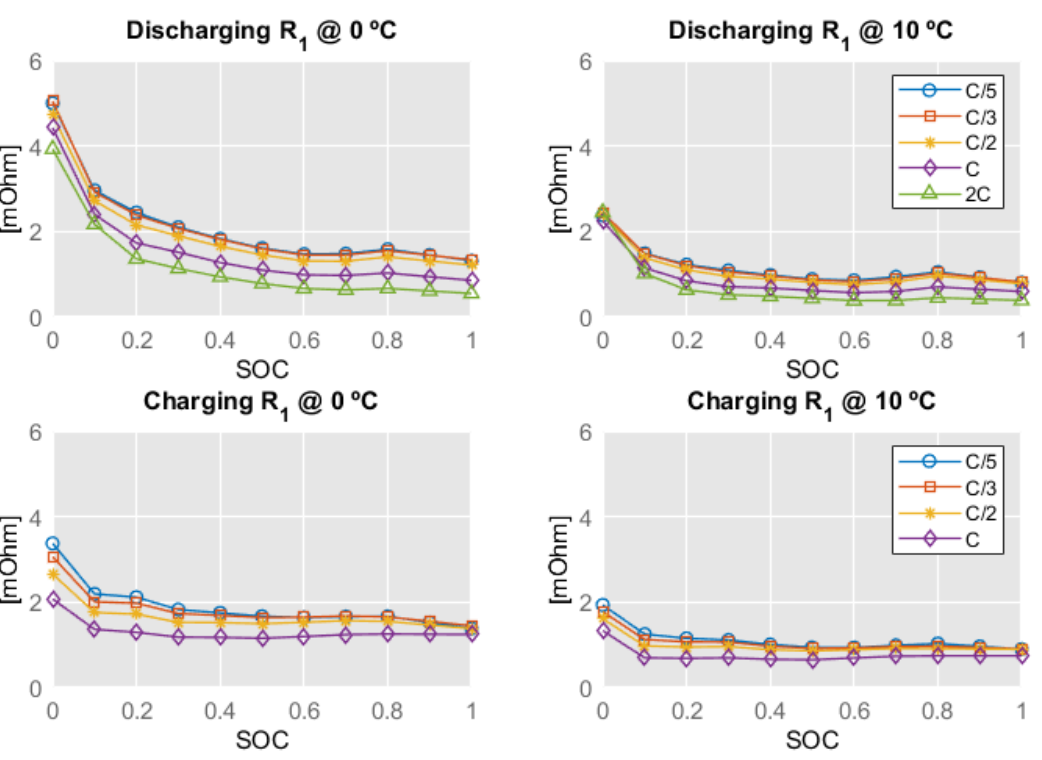
Figure 8. Charge transfer resistance ( R 1 ) in charge and discharge from HPPC test @ 0 – 10 °C.